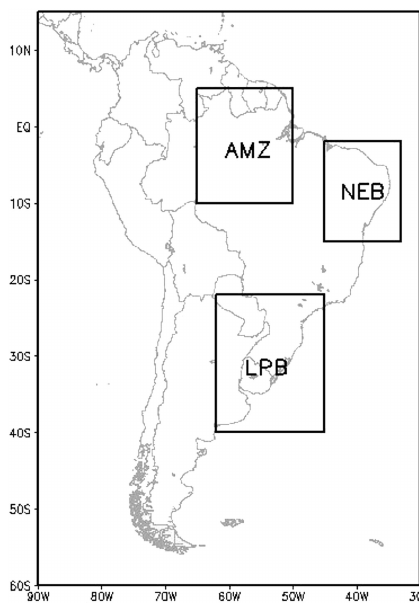
Figure 1. Illustration of the study areas of the defined